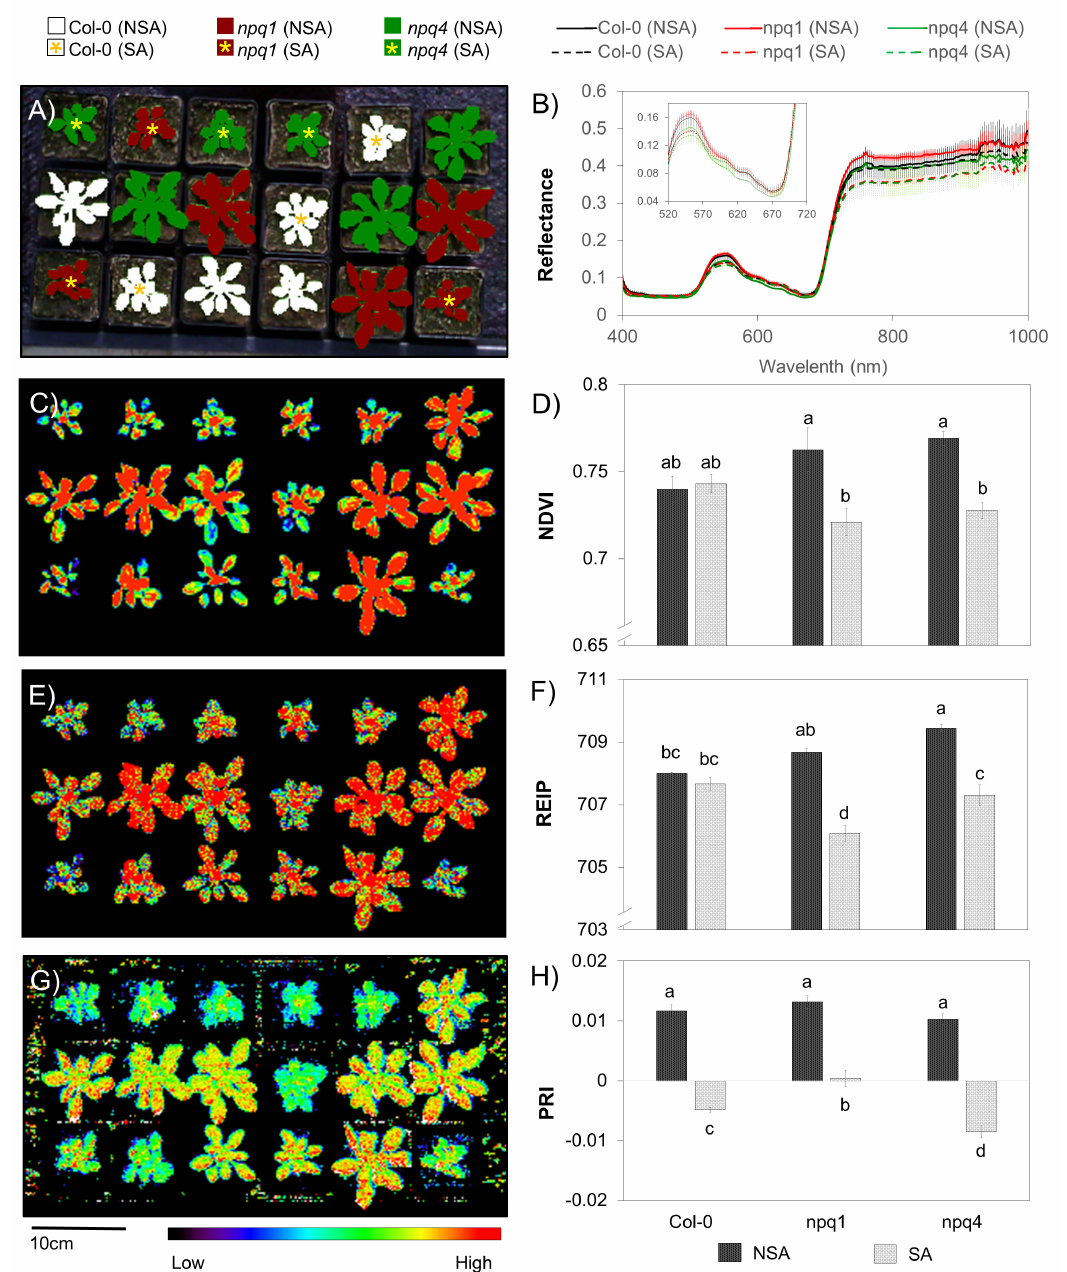
Figure 6. Differences observed between non-stress acclimated (NSA) and stress acclimated (SA) Arabidopsis wildtype (Col-0) and NPQ-deficient mutants ( npq1 and npq4 ) as shown by computed spectral ratios. Left panel shows the false-colour images of selected ROIs ( A ); NDVI ( C ); REIP ( E ); and PRI ( G ) computed from spectral information captured by the Specim IQ camera. Right panel shows the computed means ± standard errors of reflectance values ( B ); NDVI ( D ); REIP ( F ); and PRI ( H ) from three individual plants randomly distributed in the imaging frame. Different letters indicate significant differences based on LSD ( α =